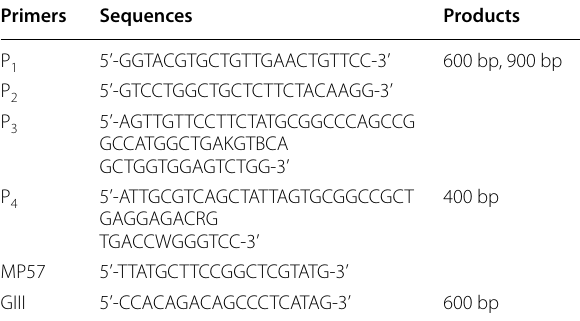
shaker at 37 °C and 250 r/min for 2 h. The M13K07 helper phage (GE Healthcare, USA) was added and